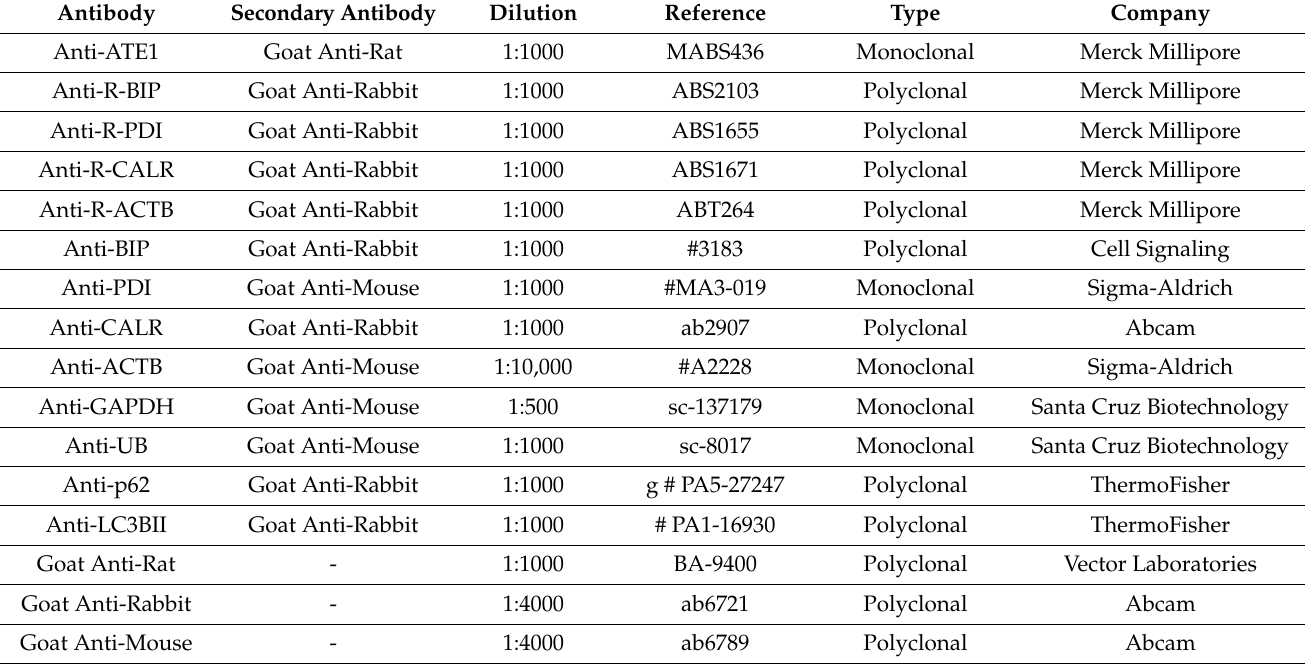
Table 1. Primary and secondary antibodies used in Western blotting analyses, with their respective dilutions, reference catalog number, type, and supplier